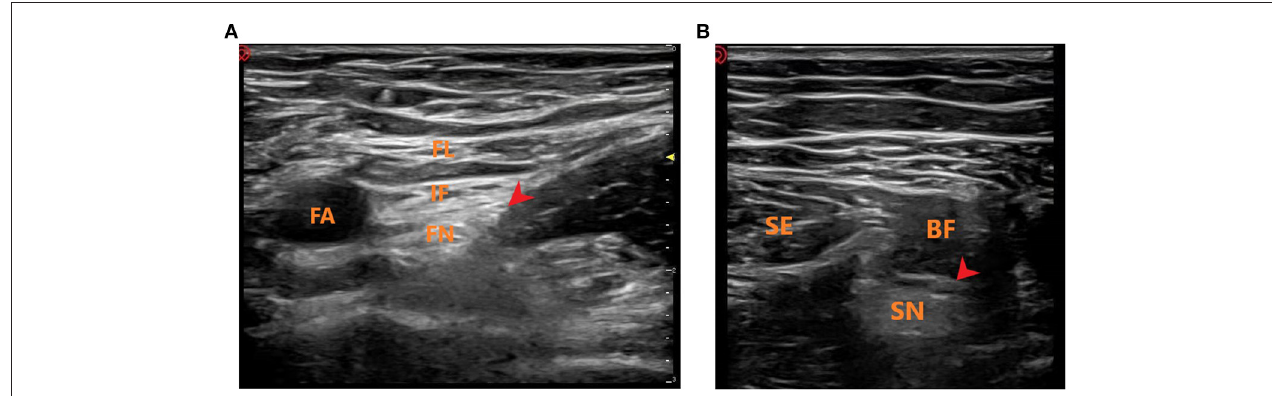
FIGURE 1 | Ultrasound-guided femoral and sciatic nerve block. (A) Ultrasound-guided femoral nerve block. FL, fascia lataI; IF, iliac fascia; FA, femoral artery; FN, femoral nerve; Red Arrow: Local anesthetic injection site. (B) Ultrasound-guided sciatic nerve block. SE, semitendinosus; BF, biceps femoris; SN, sciatic nerve; Red Arrow: Local anesthetic injection